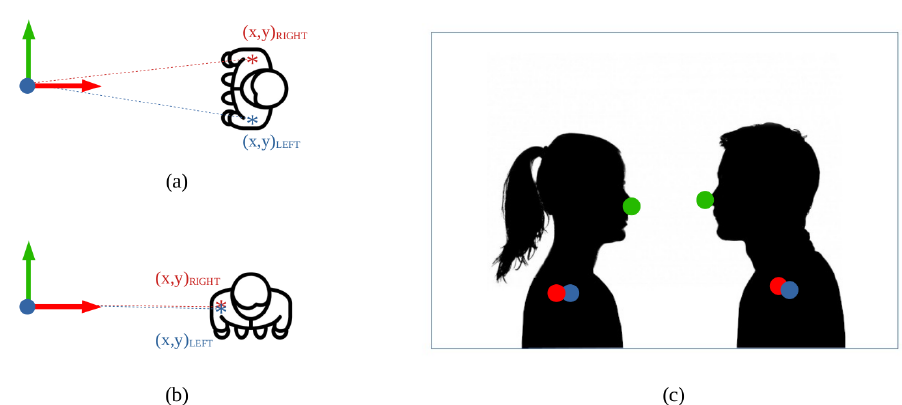
Figure 11. Extracting orientation from skeletonization: ( a ) if shoulders are clearly distinguishable, coordinates ( x , y ) RIGHT and ( x , y ) LEFT are checked to calculate the desired angle, ( b ) when the person is sideways, both shoulder coordinates coincide, so an extra point needs to be checked, ( c ) the RGB image is used to see where the nose (green dot) is placed with respect to the shoulders (red and blue dots), assigning a different predefined value depending on if it is to the left or to the